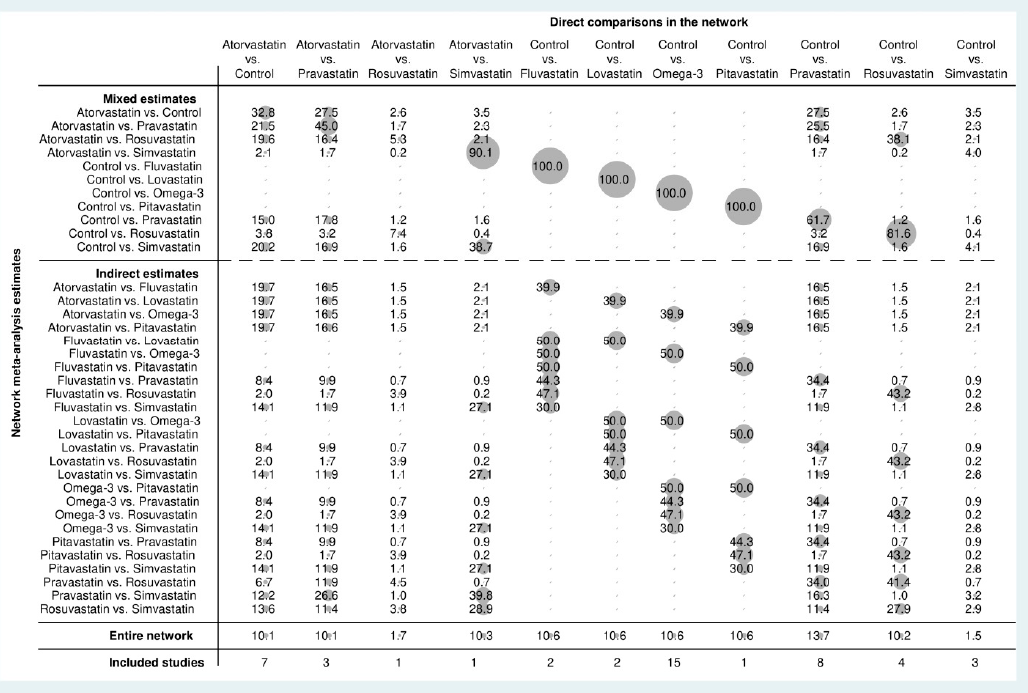
Figure A6. Contribution plot for the myocardial infarction network. The size of the square is weighted as the percentage (as number) of the contribution of the direct estimate (horizontal axis) to the network estimate (vertical axis).